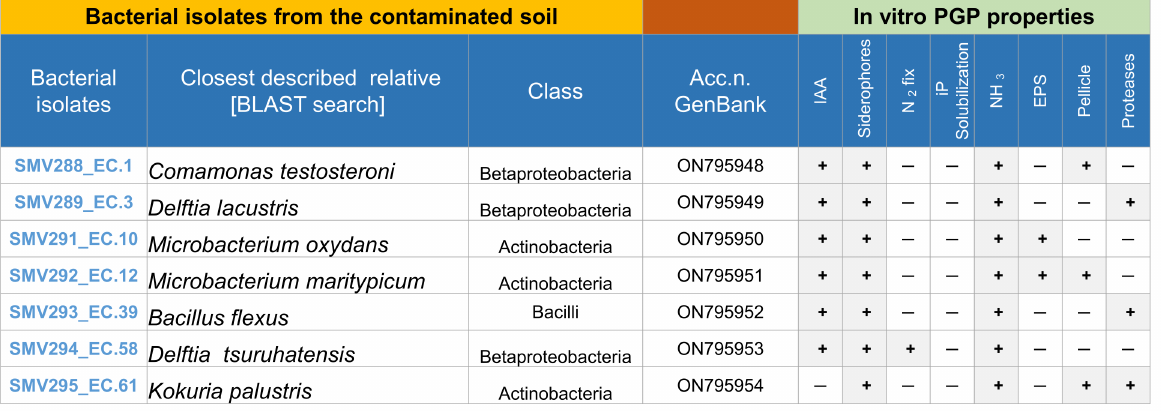
Figure 2. Second set of arsenic-tolerant bacteria isolated from a different soil contaminated with As. GenBank Accession number, metal tolerance, and in vitro PGP properties are